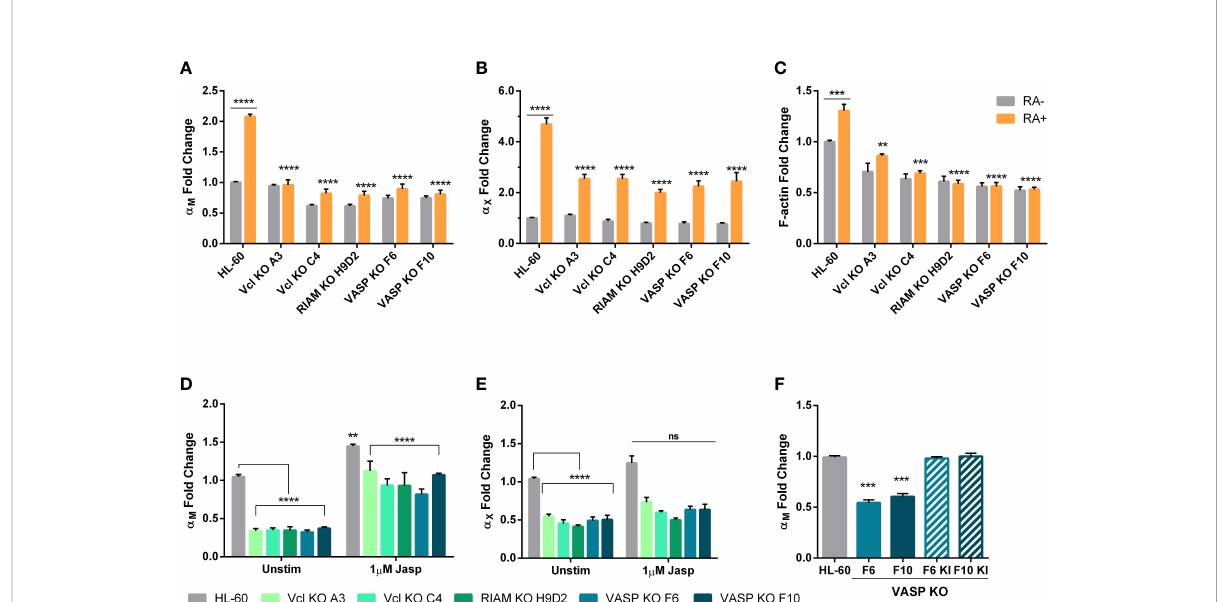
FIGURE 3 Upregulation of a M and a X expression during HL-60 neutrophilic differentiation depends on Vinculin, RIAM and VASP expression and is related cellular F- actin content. (A, B) Vinculin (Vcl), RIAM and VASP knockout cell lines and HL-60 parental cells were differentiated into neutrophilic- like cells with 1 m M all- trans retinoic acid treatment (RA+) or maintained undifferentiated (RA-), and expression of a M and a X integrins was analyzed by fl ow cytometry. (C) Cellular F-actin content was analyzed using fl uorescently labeled phalloidin in HL-60 knockout cell lines and parental cells, in undifferentiated or differentiated cells. (D, E) Vinculin, RIAM and VASP knockout cell lines and HL-60 parental cells were treated with a 2 h 1 µM jasplakinolide stimulation, followed by a 24 h resting period during neutrophilic differentiation. Then, expression of a M and a X integrins was analyzed by fl ow cytometry. (F) Expression of a M integrin was analyzed in VASP F6 and F10 knockout clones and in VASP knock-in polyclonal cell lines F6 KI and F10 KI. Results are represented as GMFI relative to HL-60 wild type levels and are from at least 3 independent experiments done in triplicate. Data are presented as mean ± SD, where the error bars denote standard deviation. Signi fi cance (ANOVA) has been calculated with respect to HL-60 controls, ** denotes p<0.01, *** p<0.005, and **** p<0.0001, and ns denotes no signi fi